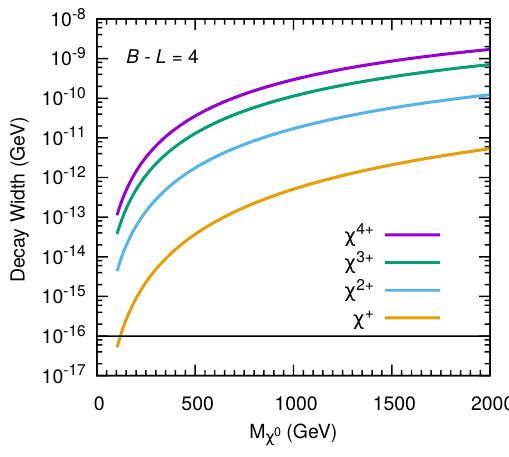
Figure 4 . Total decay width of the charged states a function of the neutral state’s mass for ( B L ) = 4 case, assuming M W (cid:0) 10 (cid:0) 16 GeV, the particle decays outside the